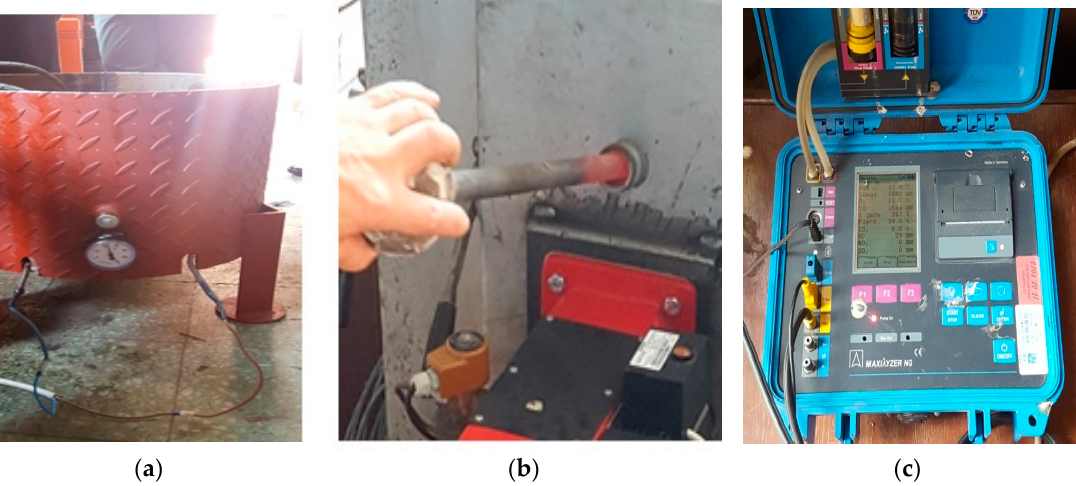
Figure 3. Measuring installation: ( a ) thermocouple for measuring the temperature of the mixture; ( b ) thermocouple for measuring the temperature inside the boiler; ( c ) MAXILYZER NG-type exhaust gas analyzer.